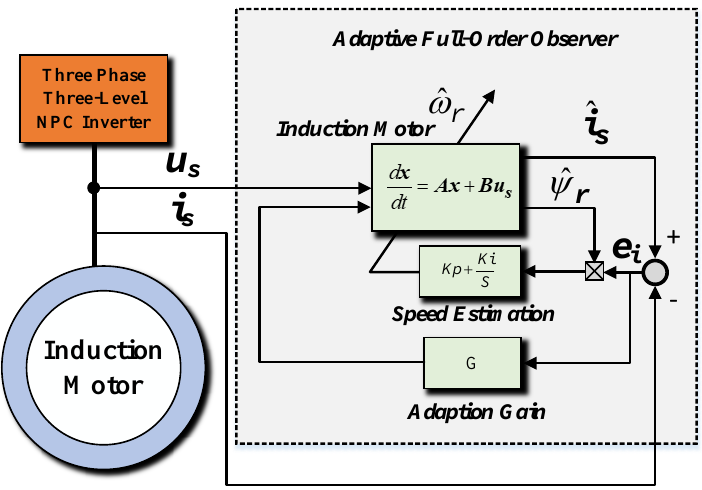
Figure 6. The general configuration of the model reference adaptive systems.